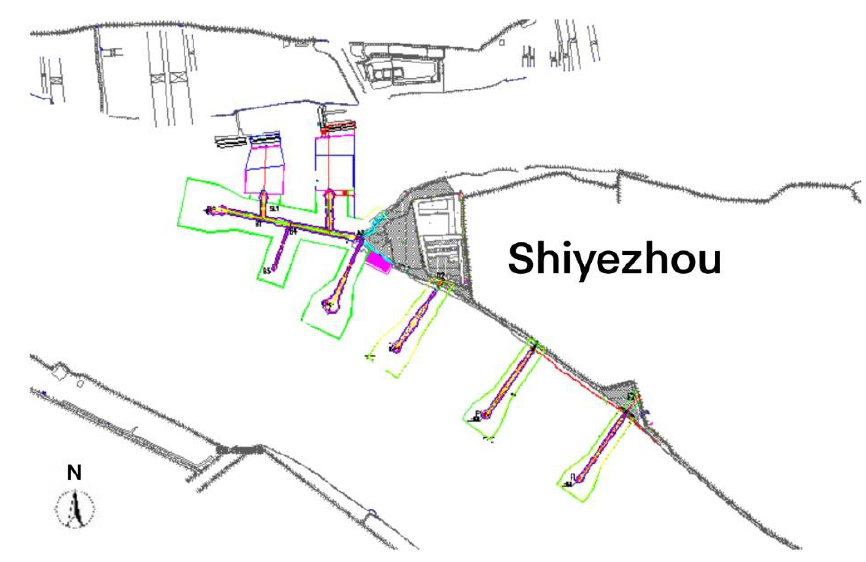
Figure 13. Layout of regulating structure in Shiyezhou Waterway.